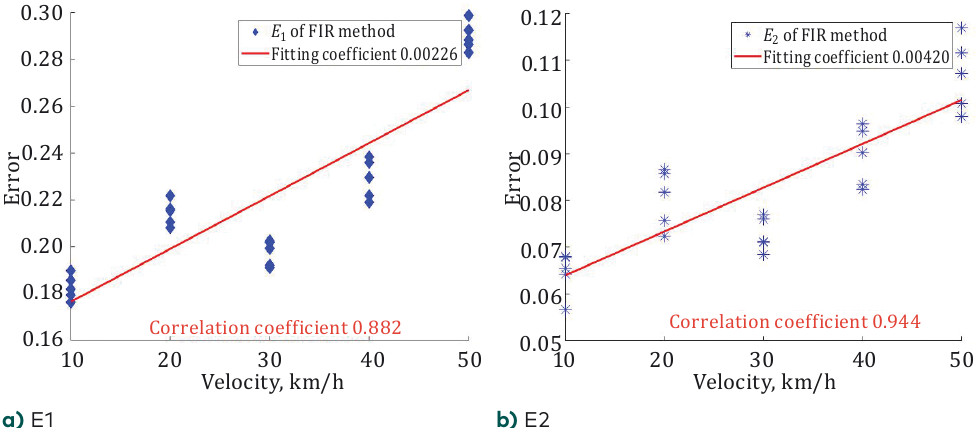
Figure 6. Error analysis of the FIR